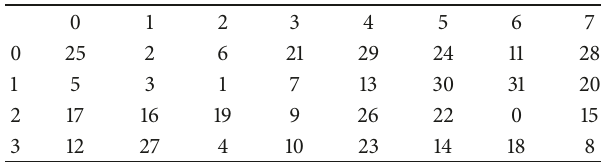
Table 7: The proposed 5 × 5 substitution-box.